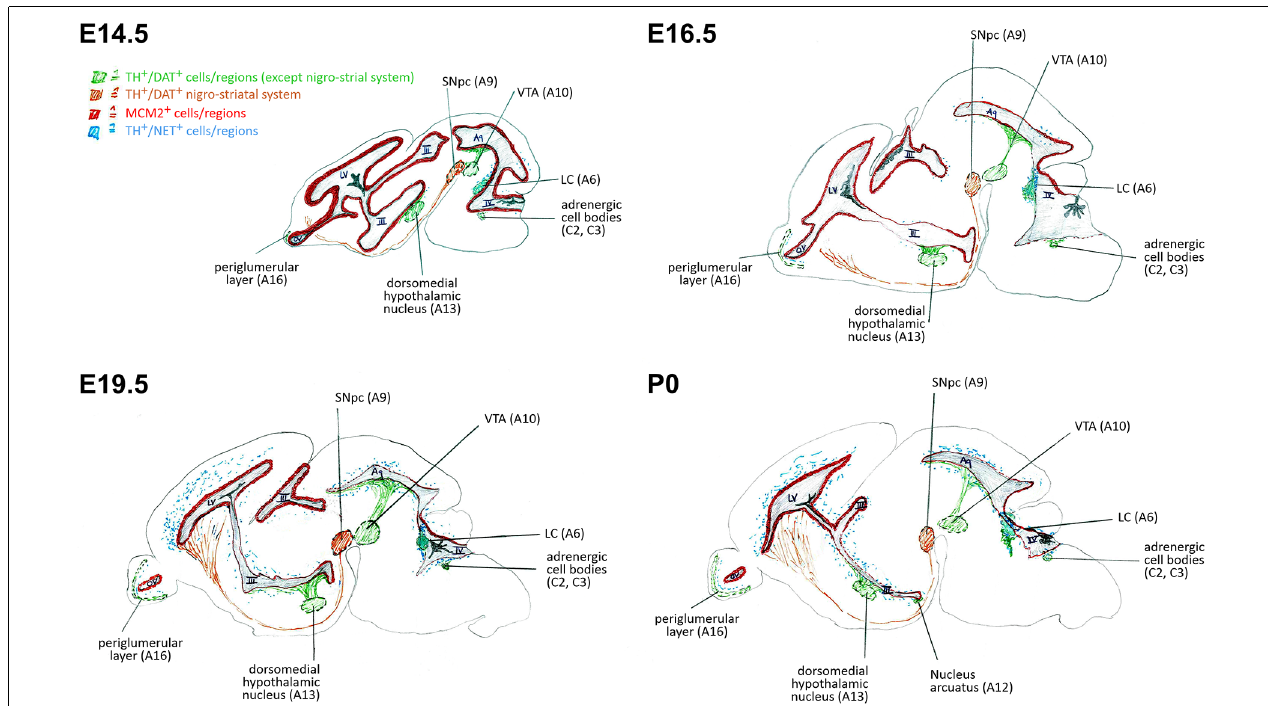
FIGURE 5 | Schematic representation of correlations of neural stem/progenitor cell proliferation and catecholaminergic innervation within VZ/SVZ regions at E14.5, E16.5, E19.5, and P0. III, third ventricle; IV, fourth ventricle; Aq, aqueduct; DAT, dopamine transporter; LC, locus coeruleus ; LV, lateral ventricle; MCM2, mini-chromosome maintenance protein 2; NET, norepinephrine transporter; OV, olfactory ventricle; SNpc, substantia nigra pars compacta ; TH, tyrosine hydroxylase; VTA, ventral tegmental